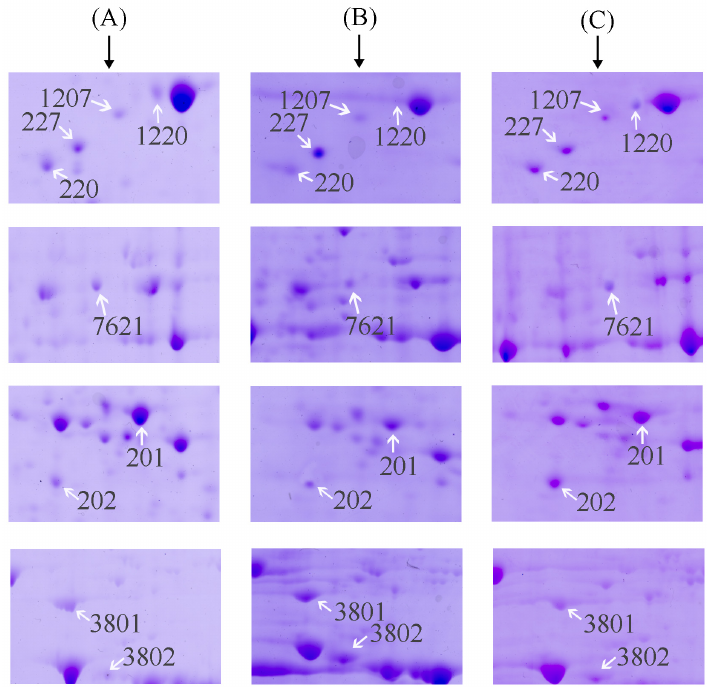
Figure 3. The expanded region of differentially expressed protein spots. The regions were cropped from the representative gel as shown in Figure. 2. The proteins shown by arrow were the differentially expressed proteins. ( A ) Normal group; ( B ) Model group; and ( C ) AMP-treated